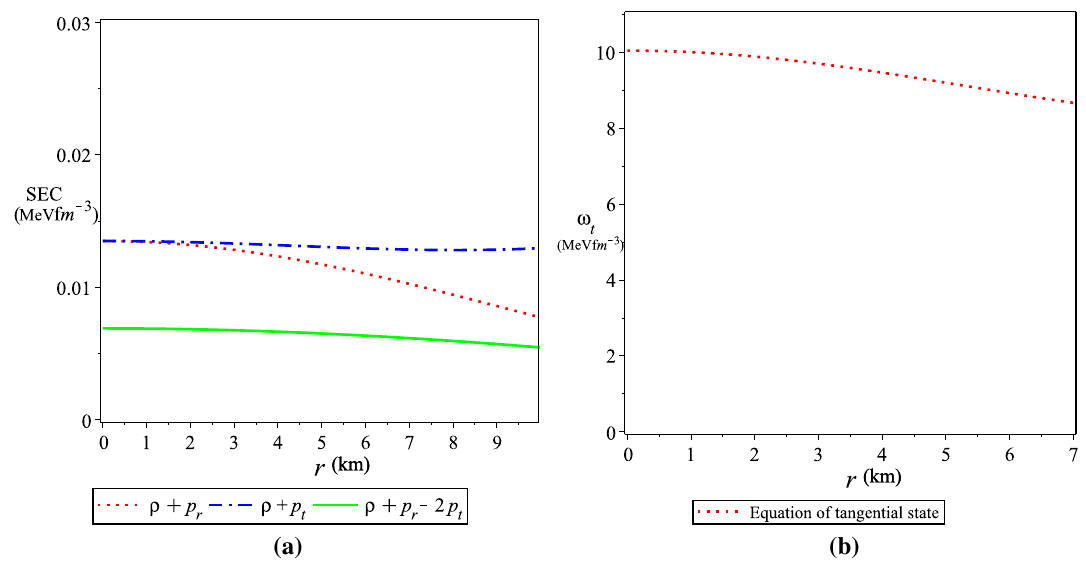
Fig. 8 Plot of the density ρ in MeVfm 3 versus the radial pressure p r and tangential pressure p t MeVfm 3 , using the constants constrained by PSR J